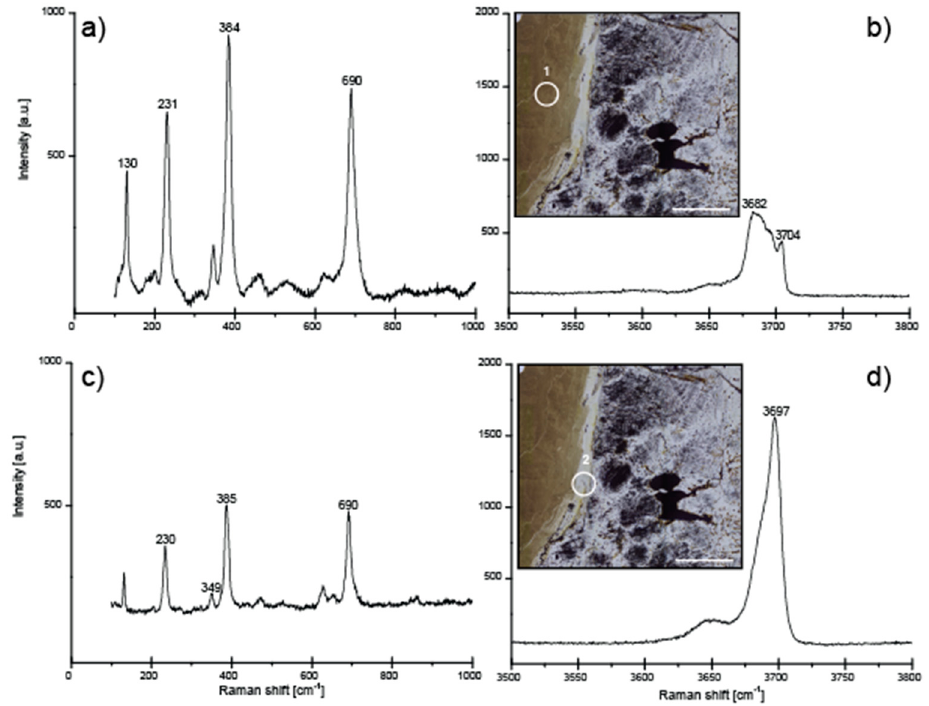
Figure 2. Raman spectra in the low- and high-wavenumber regions of lizardite (( a ) and ( b ), respectively) and chrysotile (( c ) and ( d ), respectively). Photomicrographs show the positions of the spots in which the spectra were acquired; scale bar: 0.2 mm.